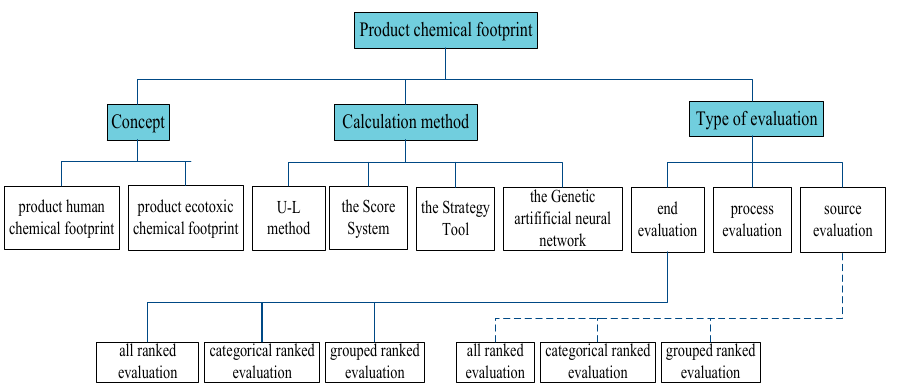
Figure 1. Overview of the conceptual classification of product chemical footprints based on toxic pressure.